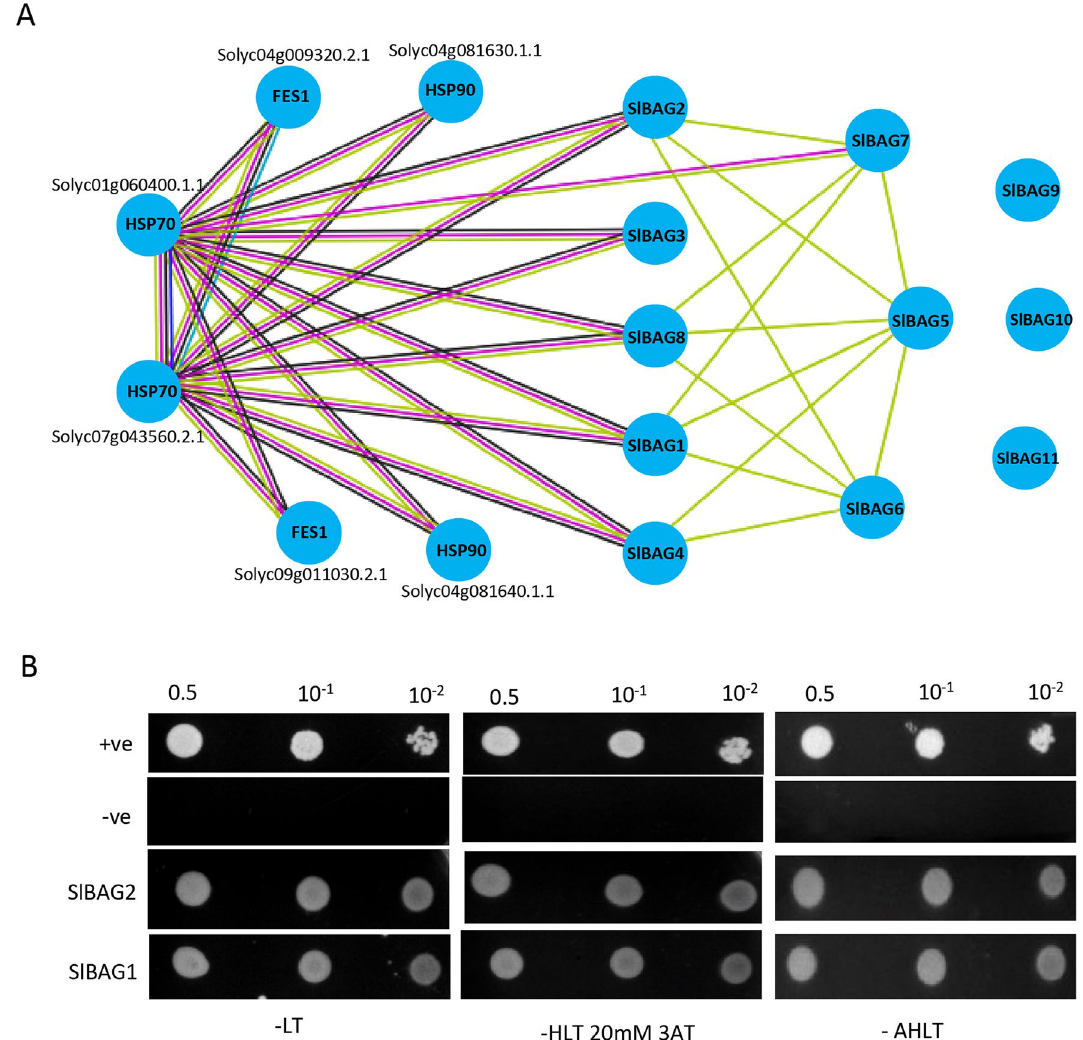
Figure 7. Protein–protein interaction analysis of SlBAG proteins. ( A ) Predictive PPI networks obtained from STRING (https:// string- db. org/) with tomato SlBAG proteins. Red line—indicates the presence of fusion evidence; Green line—neighborhood evidence; Blue line—cooccurrence evidence; Purple line—experimental evidence; Yellow line—textmining evidence; Light blue line—database evidence; Black line—coexpression evidence. ( B ) Yeast two hybrid Assay showing interaction of SlBAG1 and SlBAG2 with HSP70 proteins of